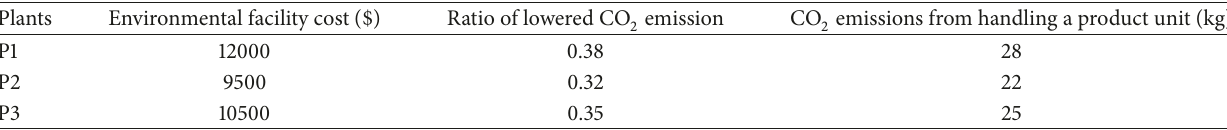
Table 4: Relevant parameters for the three plants.